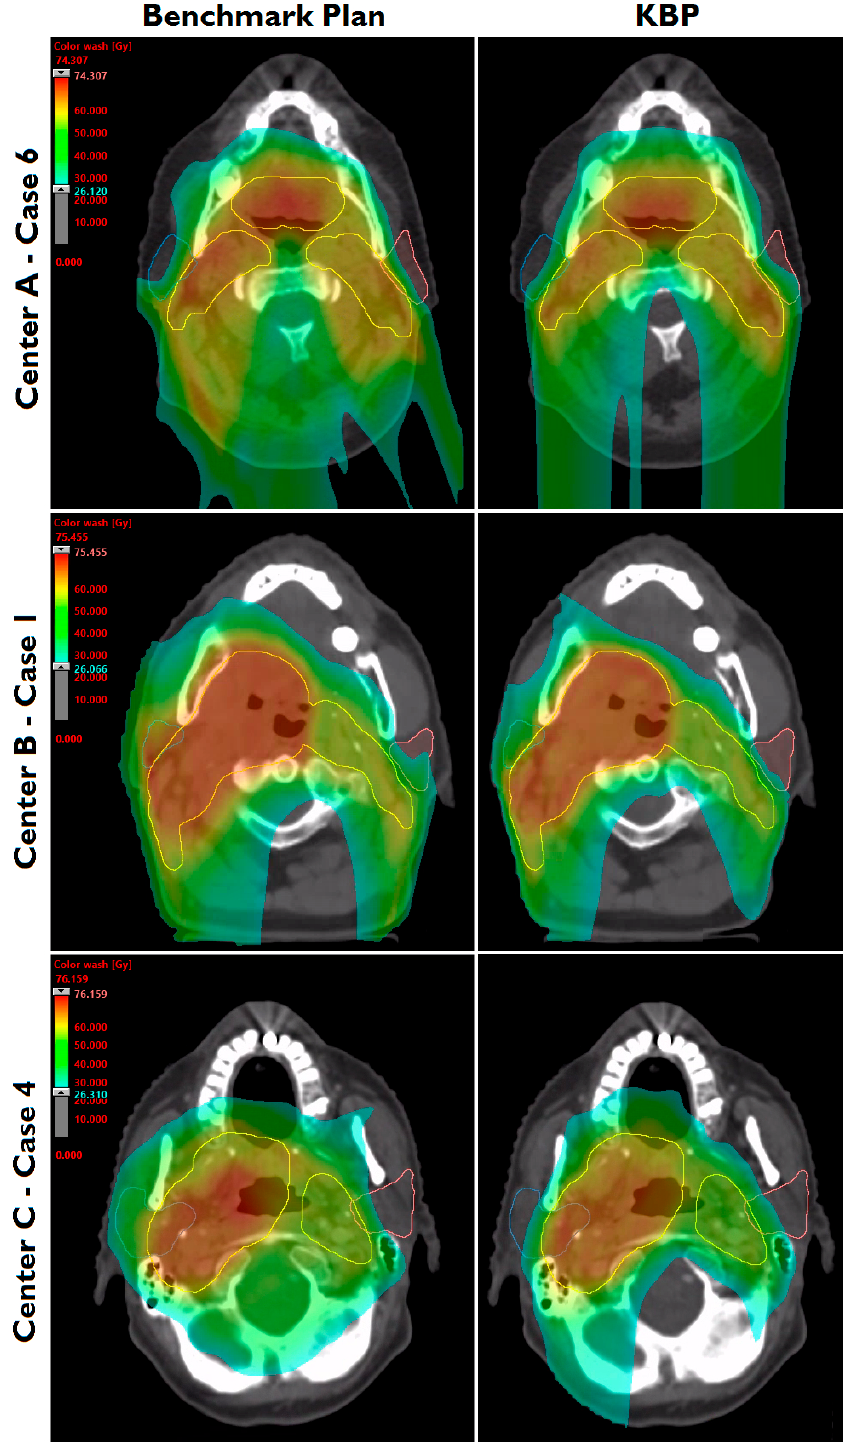
Figure 2. Dose distributions of benchmark plans and knowledge-based plans (KBPs) for one evaluation patient from each external center. Parotid glands (blue, pink) and the composite planning target volume (yellow) are shown.